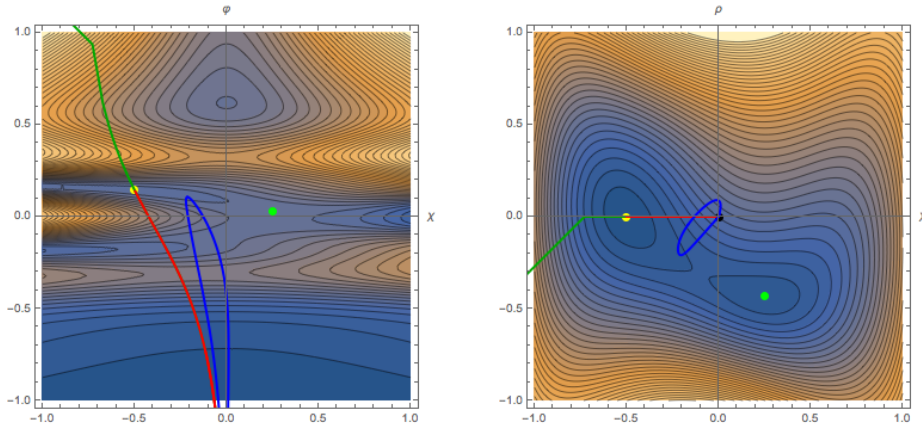
Figure 1 . Contour plot of the SU(3)-invariant superpotential and (cid:13)ows. The N = 2, SU(3) (cid:2) U(1) and N = 1, SU(3) critical points are denoted by yellow and green dots, respectively. In the left plot, the 3d N = 8 SYM phase is located at (cid:31) = 0 and ’ ! (cid:0)1 . In the right plot, the 3d N = 8 SYM phase is at the origin, and is denoted by a black